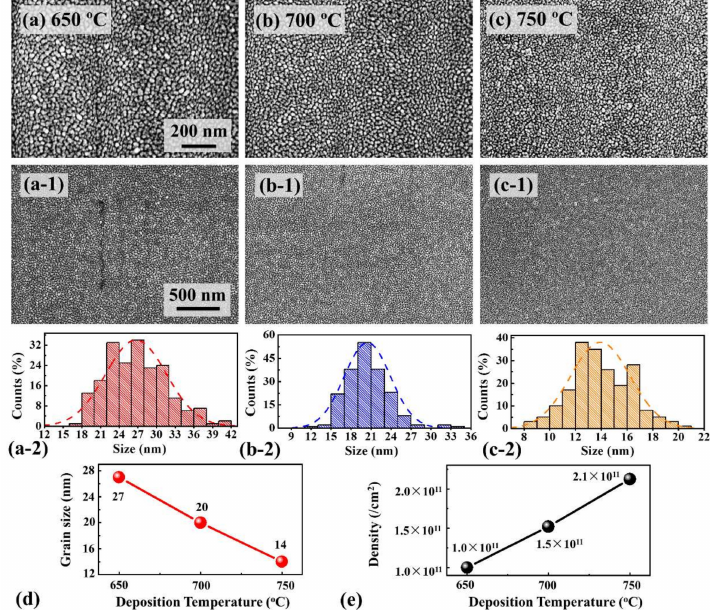
Figure 3. Scanning electron microscopy (SEM) images of PLZT thin films fabricated at various temperatures: ( a ) 650; ( b ) 700; and ( c ) 750 ◦ C. SEM images are: 1.2 ( x ) × 0.8 ( y ) µ m 2 ( a – c ); and 2.4 ( x ) × 1.6 ( y ) µ m 2 in ( a-1 – c-1 ). ( a-2 – c-2 ) The distribution histogram and Gaussian fitting of the grain diameter of PLZT thin films; ( d ) the average grain size; and ( e ) average density of each